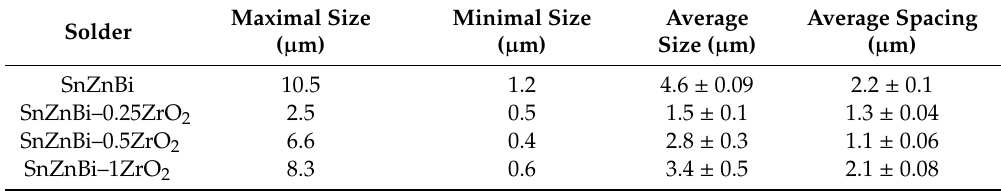
Figure 12. Microstructure of: ( a ) SnZnBi solders after being reflowed for 5 min; ( b ) SnZnBi–0.5Ni composite solders after being reflowed for 30 min; ( c ) SnZnBi solders after being reflowed for 30 min; ( d ) SnZnBi–0.5Ni composite solders after being reflowed for 30 min [77]. Table 1. Grain size and spacing of Zn-rich phase in the SnZnBi–xZrO 2